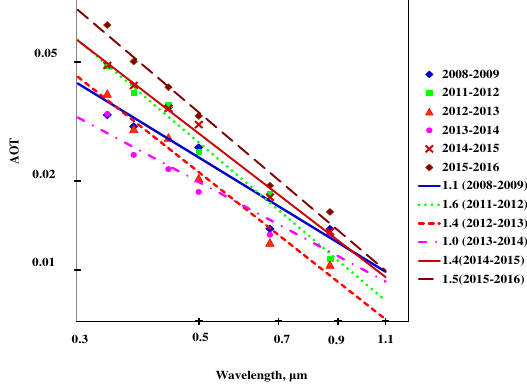
Figure 1 Spectra of AOT in Antarctic coastal zone